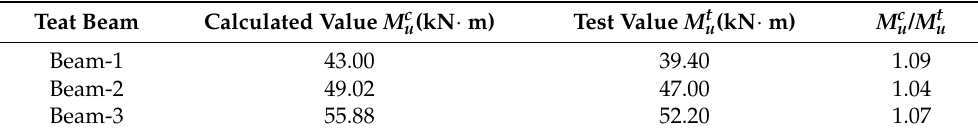
Table 5. Calculated and test values of ultimate failure bending